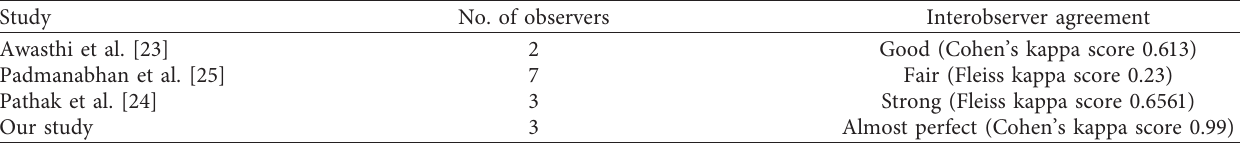
Table 5: Comparison of interobserver reproducibility of among various studies.